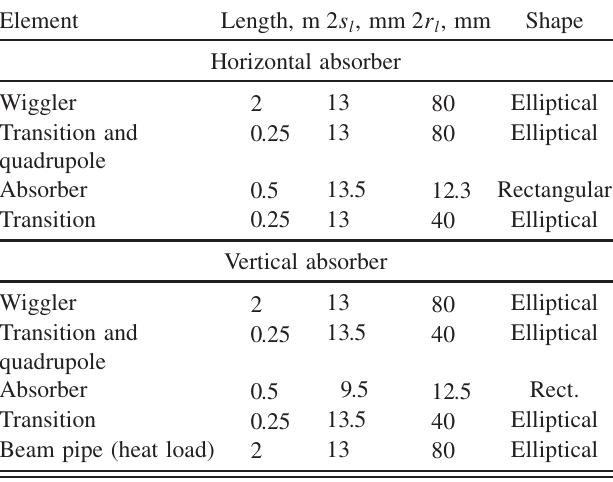
TABLE VII. Lattice for heat load calculation of synchrotron radiation.